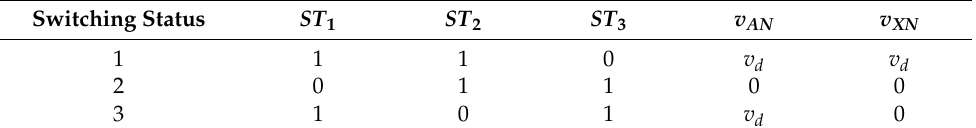
Figure 1. The six-switch converter topology. Table 1. Switching status of the six-switch converter.